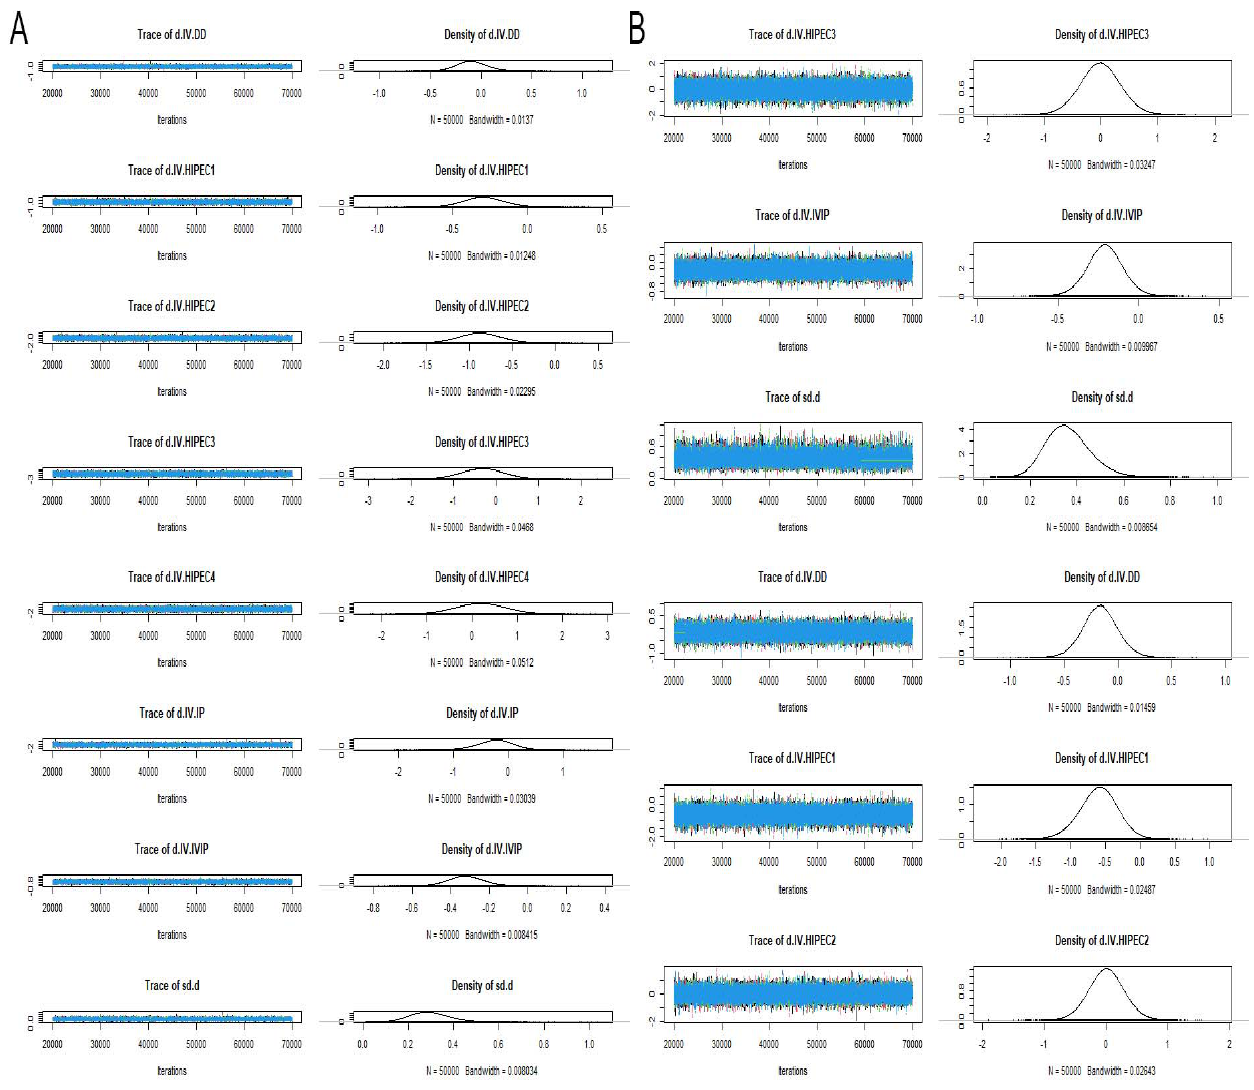
Figure 3. Trac and marginal density plots of OS ( A ) and PFS ( B ).